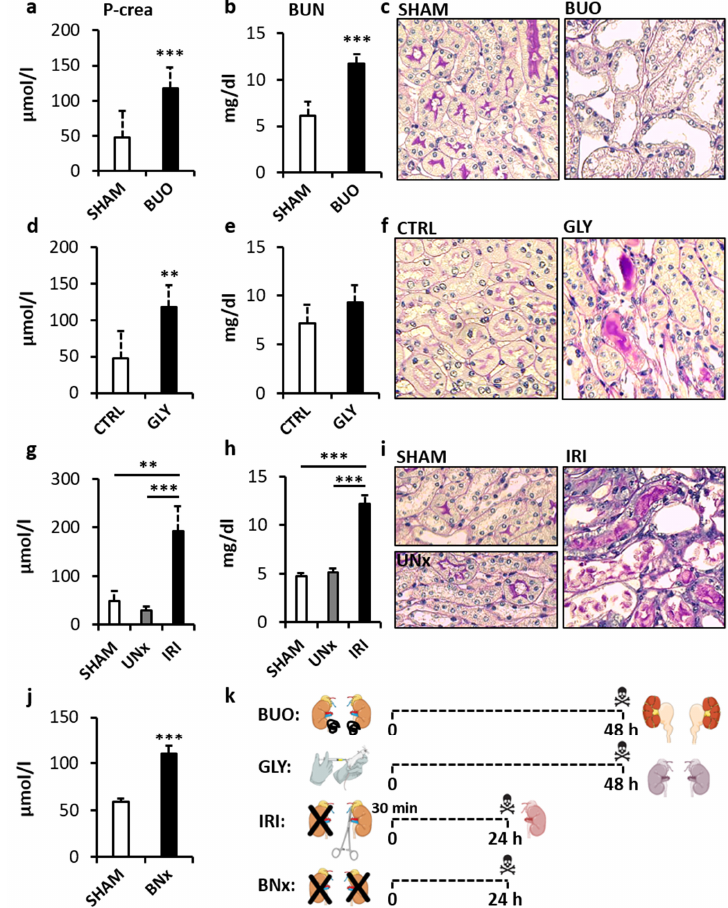
Figure 1. Renal function and histopathological assessment of mice with acute kidney injury (AKI). Bilateral ureteral obstruction: ( a ) creatinine; ( b ) BUN; ( c ) left panel—normal renal architecture, right panel—tubular dilation and atrophy. Glycerol-induced AKI: ( d ) creatinine; ( e ) BUN; ( f ) left panel—normal renal architecture, right panel—tubular atrophy and proteinuric casts. Ischemia–reperfusion injury: ( g ) creatinine; ( h ) BUN; ( i ) left panel—normal renal architecture, right panel—tubular atrophy and dilation, epithelial cell necrosis and cell shedding, and proteinuric casts. Bilateral nephrectomy: ( j ) creatinine. Overview of the preparation of the individual models ( k ). BUO—bilateral ureteral ligation, BUN—blood urea nitrogen, GLY—glycerol-induced AKI, UNx—unilateral nephrectomy, IRI—ischemia–reperfusion injury, BNx—bilateral nephrectomy. ** denotes p < 0.01, *** denotes p < 0.001. Data are presented as mean + SD. Histological images show periodic acid Schiff stain (PAS), magnification